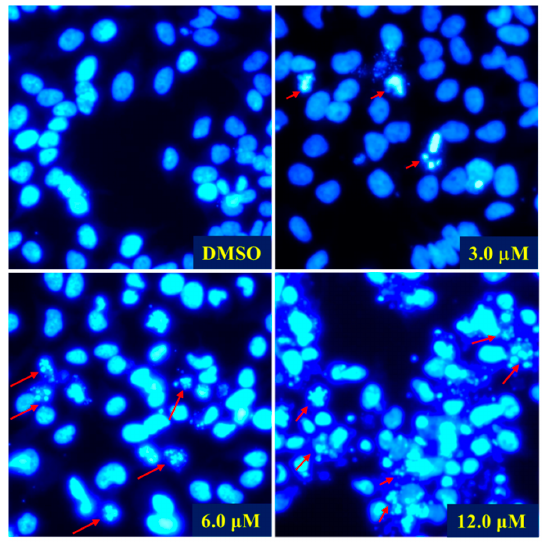
Figure 6. Morphological observation for Hela cells. HeLa cells were treated with vehicle control (DMSO) and Compound 2 at different concentrations for 48 h, stained with DAPI and viewed under a fluorescence microscope at a magnification rate of 200. Red arrows represent the altered nuclear morphology in a dose-dependent manner.